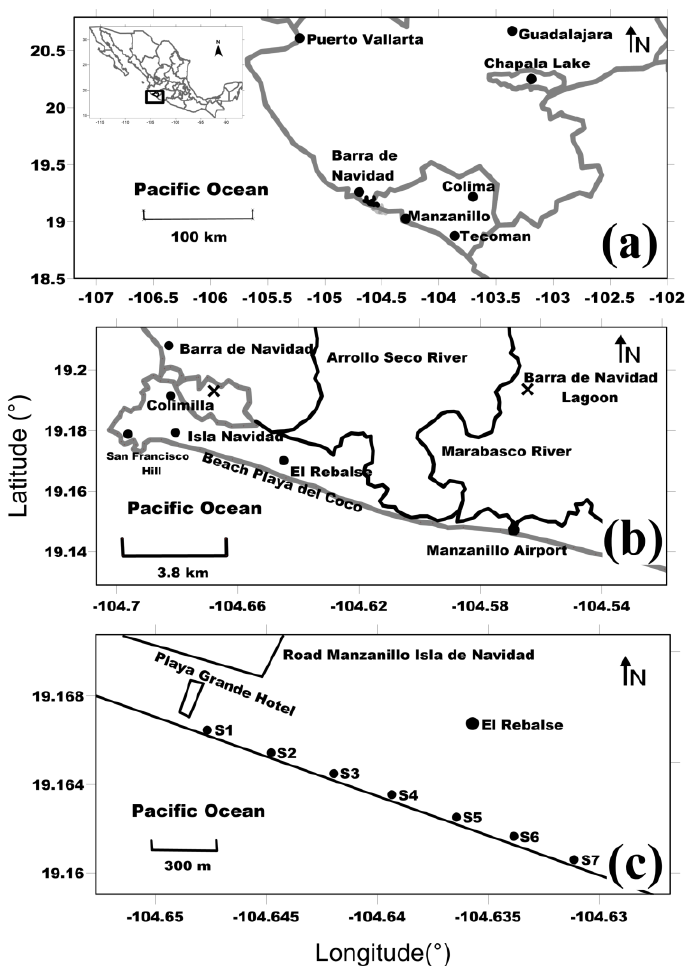
Figure 1. ( a ) Location of Playa del Coco along the Pacific Coast. ( b ) Location of Playa del Coco with respect to Colimilla and Manzanillo Airport. ( c ) Location of the seven sampling stations. Study area of Playa del Coco depicting the mouths of the Marabasco River and the seven sampling stations. A previous design of the sampling points was carried out using a GPS, establishing a distance between points of 300